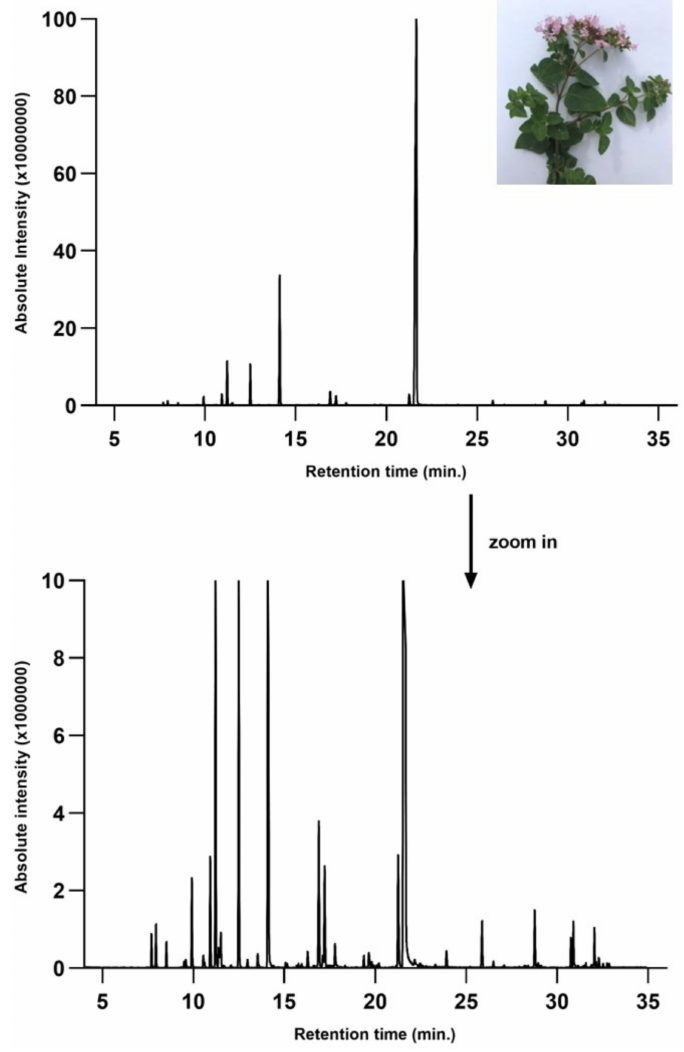
Figure 1. Chromatographic profile of OEO. Table 1. Identified compounds by